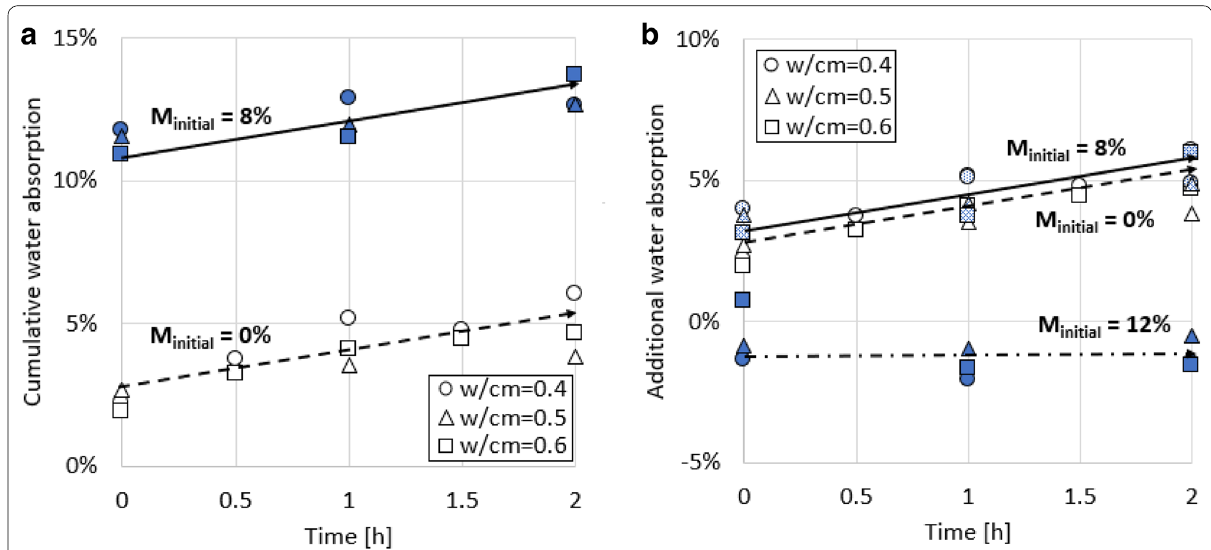
Fig. 4 Effect of the initial moisture content: a cumulative or b additional water absorption of LWA.